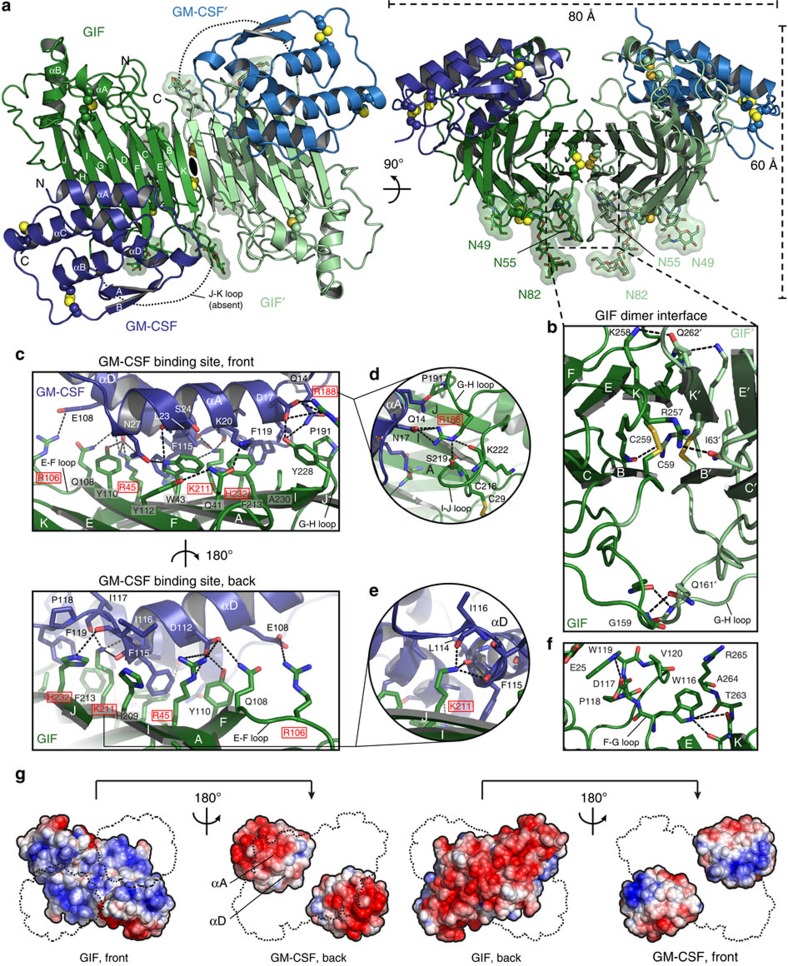
Crystal structure of the GIF:GM-CSF complex.(a) Dimeric GIF (pale green/dark green) is bound by two copies of ovine GM-CSF (blue/dark blue). Disulfides are shown as yellow spheres and N-linked glycans are depicted as sticks with transparent surface. The missing loop connecting β-strands βJ and βK is represented as a dashed line. The two-fold non-crystallographic symmetry (NCS) axis present at the center of the GIF dimer interface is indicated as a black oval. (b) Inset showing the GIF dimerization interface. Two GIF monomers are coloured in pale and dark green, disulfides are shown as yellow sticks and polar interactions are shown as dashed lines. (c) Inset of the GM-CSF (blue) binding epitope on GIF (green). Interacting residues are shown as sticks, and hydrogen bonds/salt-bridges are shown as dashed lines. Interface residues for which mutation data is available are labeled in red (see also Fig. 6; Supplementary Fig. 5; Supplementary Table 5). (d,e) Close-up view of interactions made by GIF residues R188 and K211, respectively. (f) Inset displaying the WSXWS-like motif (WDPWV) present in the F-G loop of GIF, which is involved in stabilizing the final three C-terminal residues of β-strand K. (g) Solvent accessible surface potential representation of the GIF:GM-CSF complex and individual subunits. The cytokine binding side of GIF is characterized by a basic surface potential complementary to the acidic patch formed by helices αA and αD of GM-CSF. Visualizations were generated using the PDB2PQR74 and APBS75 software.